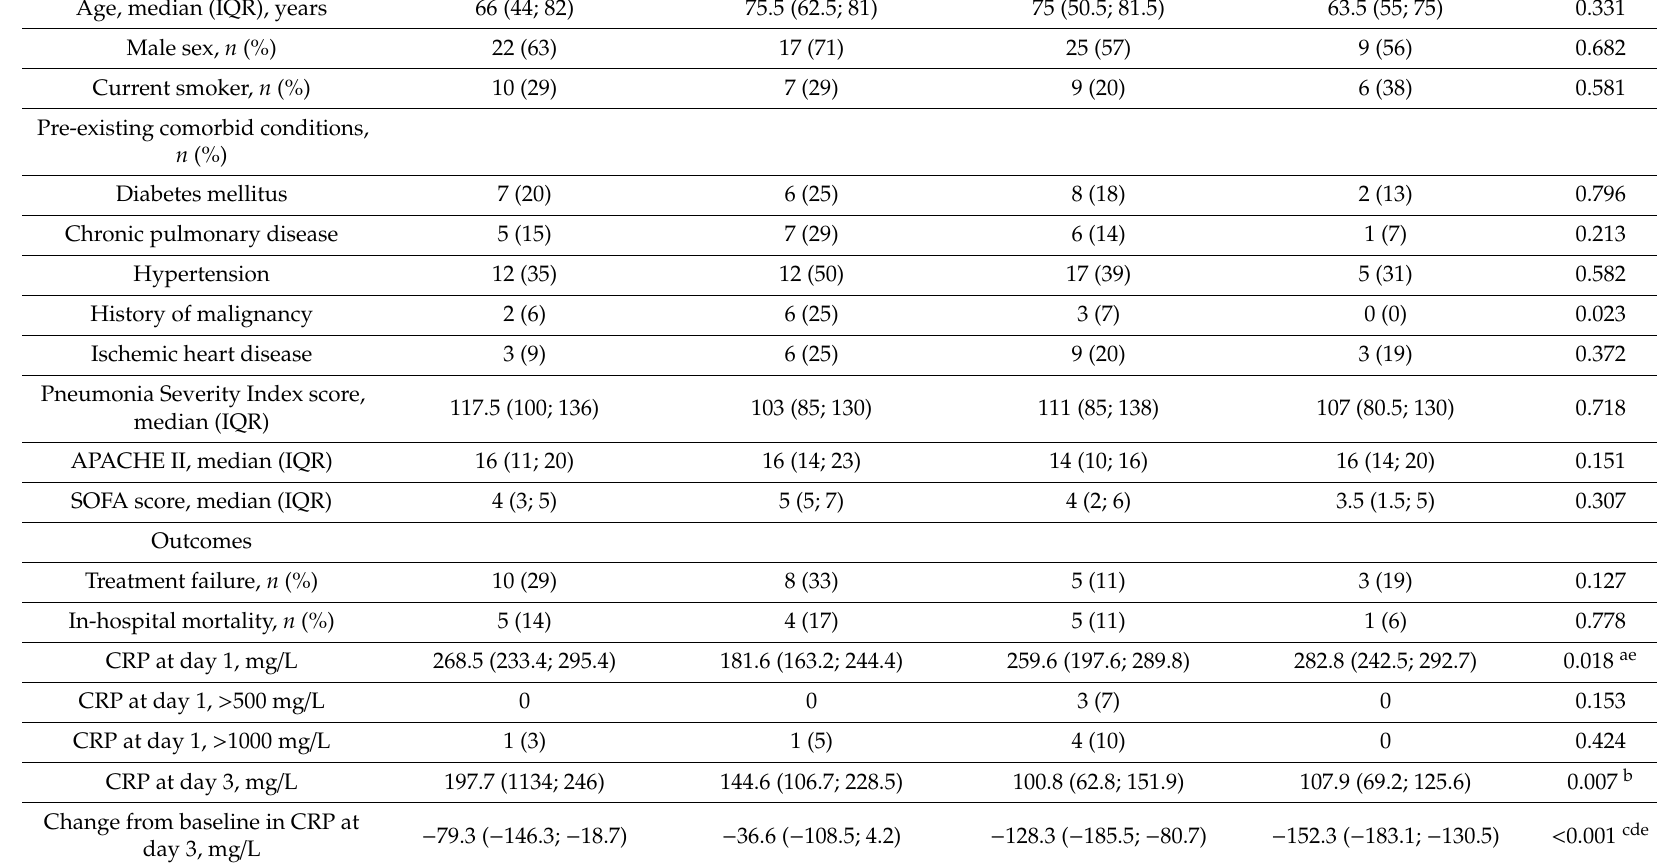
Table 1. Baseline characteristics and outcomes of the intention-to-treat population ( n = 119) and outcomes of the per protocol population ( n = 111). Methylprednisolone Methylprednisolone Placebo Patients with Placebo Patients without p value Intention-to-Treat Population Patients with Patients without Lymphopenia ( n = 35) Lymphopenia ( n = 24) Lymphopenia ( n = 44) Lymphopenia ( n = 16) Age, median (IQR), years 66 (44;